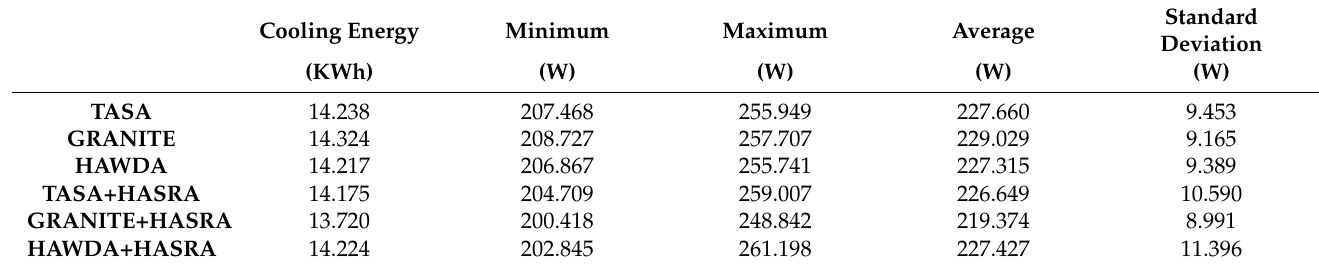
Table 7. Cooling energy consumed for 25 h workload